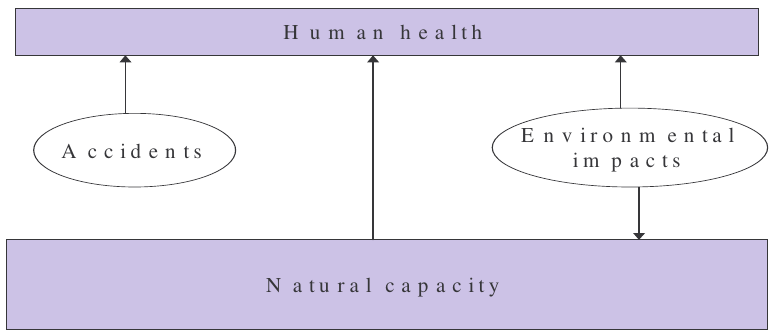
Figure 2. Inter-relationships between accidents, environment and